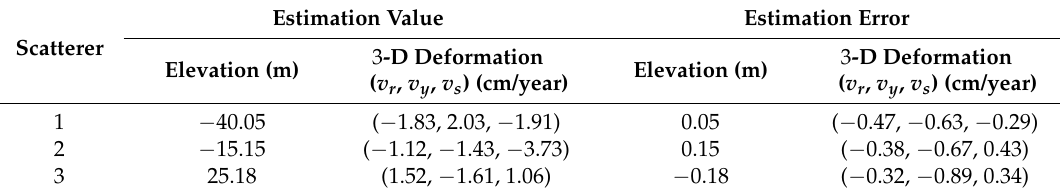
and elevation directions. Table 4. Estimation of elevation and 3-D deformation velocity of three scatterers in slant range,